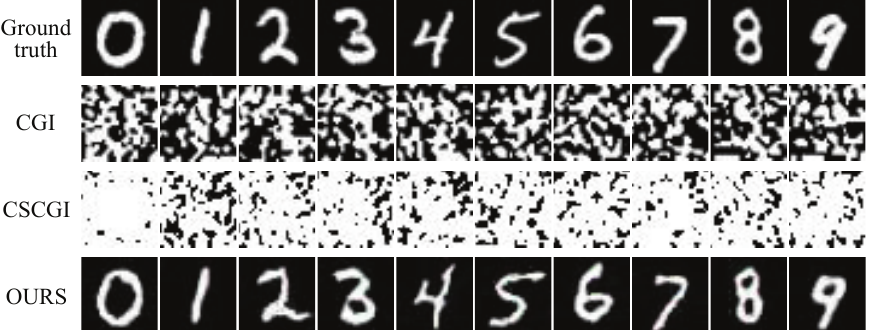
Figure 5. Comparison of simulation results from CGI, CSCGI, and our scheme (labeled as OURS) at a sampling ratio of